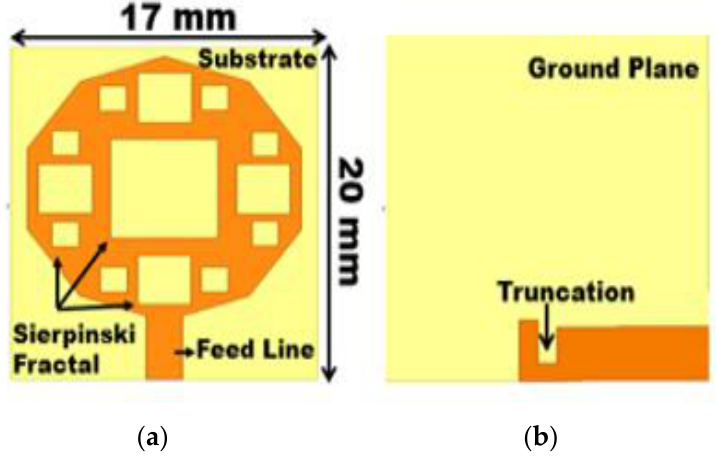
Figure 1. Top plane ( a ) and ground plane ( b ) of the proposed UWB antenna.